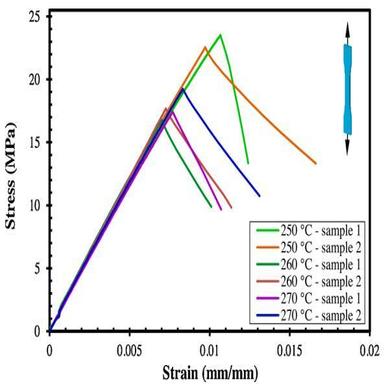
Stress-strain graph of PC/ABS FGM specimens printed in different temperatures.